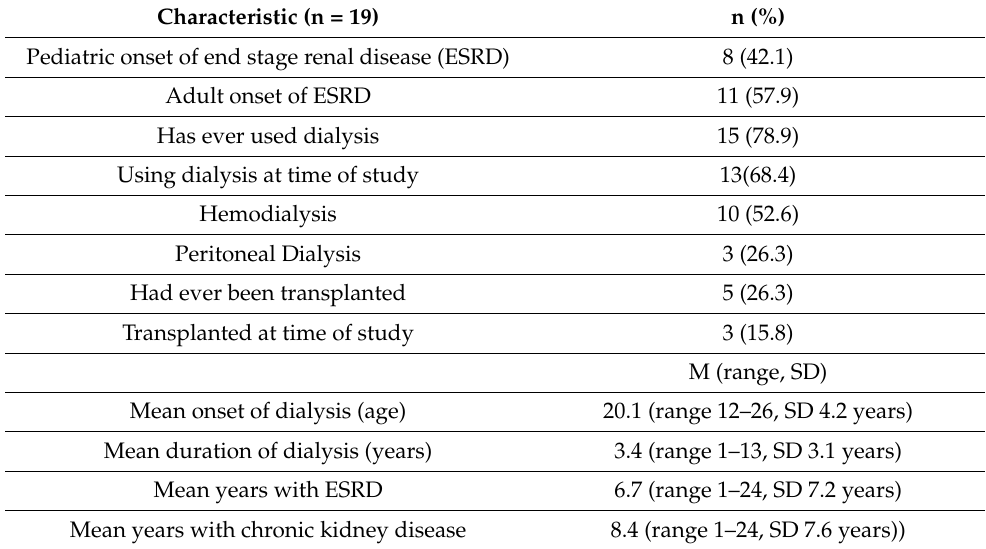
Table 2. Disease-related